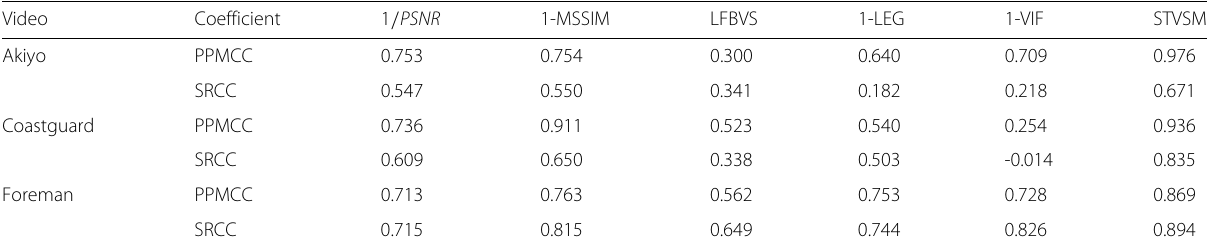
Table 4 Correlation coefficients of objective scores against subjective score (MOS) for scenario Extended-1 Video Coefficient 1 / PSNR 1-MSSIM